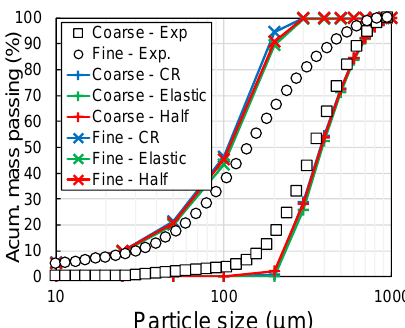
Fig. 8. PSD of products for vertical cases and 1.5 m/s varying the CoR.